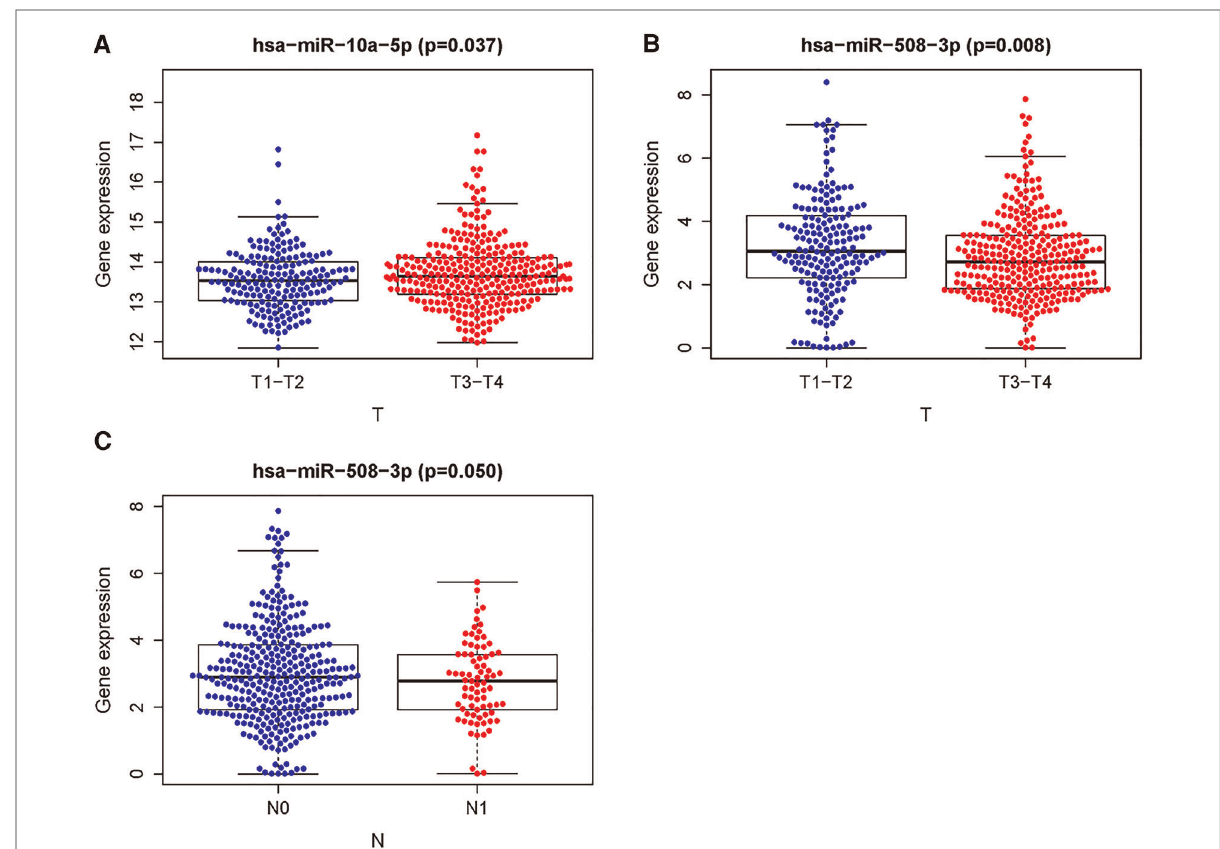
FIGURE 5 Relationships between the sDMIRs and the clinical features. Relationships between the hsa-mir-10a-5p ( A ), hsa-mir-508-3p ( B) , and T-stages, N- stages ( C